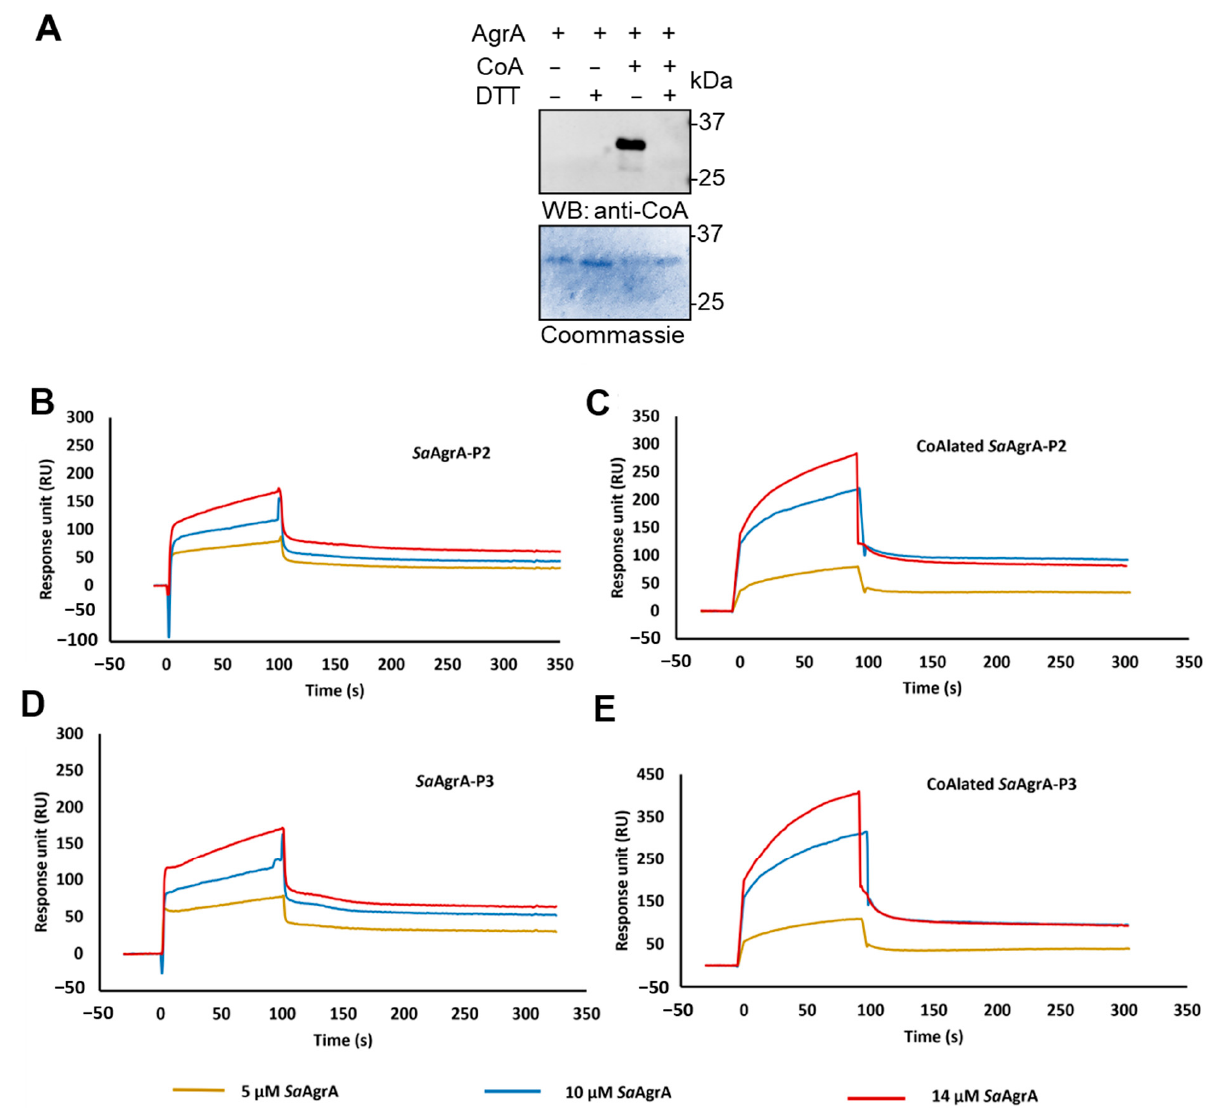
Figure 5. CoAlation of recombinant Sa AgrA differentially affects its DNA-binding activity to P2 and P3 promoters. ( A ) In vitro CoAlation of recombinant Sa AgrA was analyzed by anti-CoA Western blot. Immediately after in vitro CoAlation, interaction of Sa AgrA and CoAlated Sa AgrA to P2 and P3 promoters was analyzed by surface plasmon resonance (SPR). ( B , C ) Binding profiles of Sa AgrA and CoAlated SaAgrA to the P2 promoter are shown. ( D , E ) Binding profiles of Sa AgrA and CoAlated Sa AgrA to the P3 promoter are shown. Interaction parameters derived from the sensorgrams are compiled in Table 1. The flow and sample buffer maintained was 20 mM HEPES (pH 7.6), 250 mM KCl, and 10% glycerol.